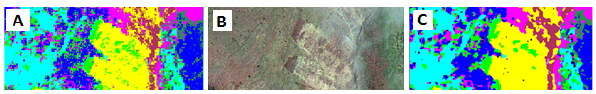
Fig. 3. Filtering operation: detail of improvement on the spatial structure of the classified map. A – classified map; B – GeoEye-1 satellite image, and C – filtering operation result. Scars are repre- sented in green, landslide tracks in yellow, vegetation in dark blue, bare soil in bright blue, clouds in pink and gravel in bordeux. Note the perfect differentiation between landslide track and bare soil, which, a priori, would be the most similar